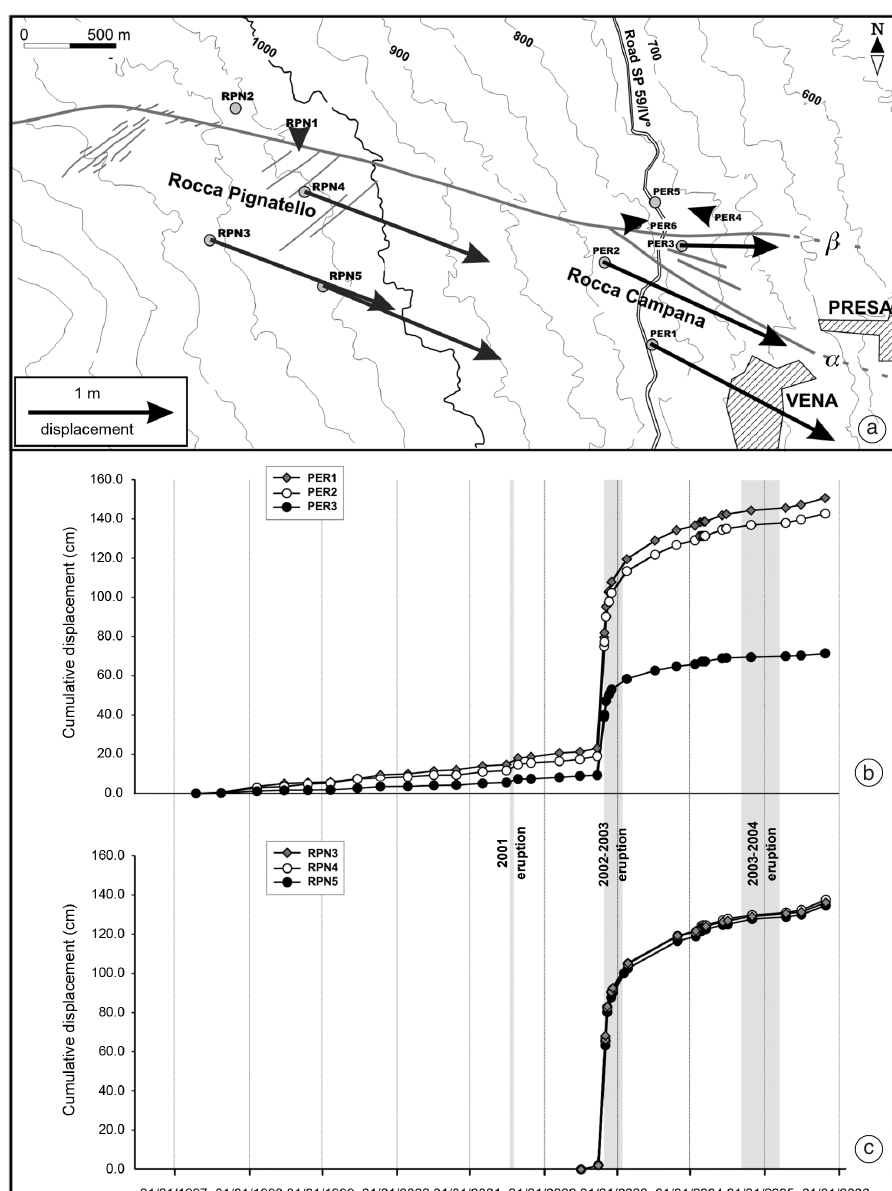
Fig. 5a-c. a) Cumulative horizontal displacements for the two GPS networks: from April 1997 to November 2005 for the RCN network, and from July 2002 to November 2005 for RPN network; b) time evolution of the displacements of some selected benchmarks of the RCN network; c) time evolution of the displacements of some selected benchmarks of the RPN